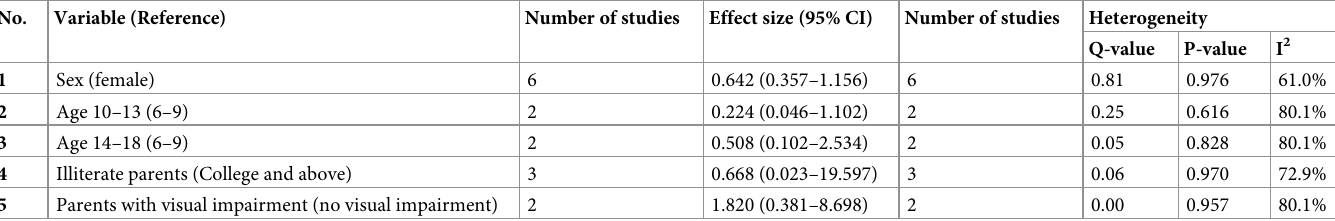
Table 2. The pooled effect size of factors of visual impairment among children in Ethiopia, 2021. No. Variable (Reference) Number of